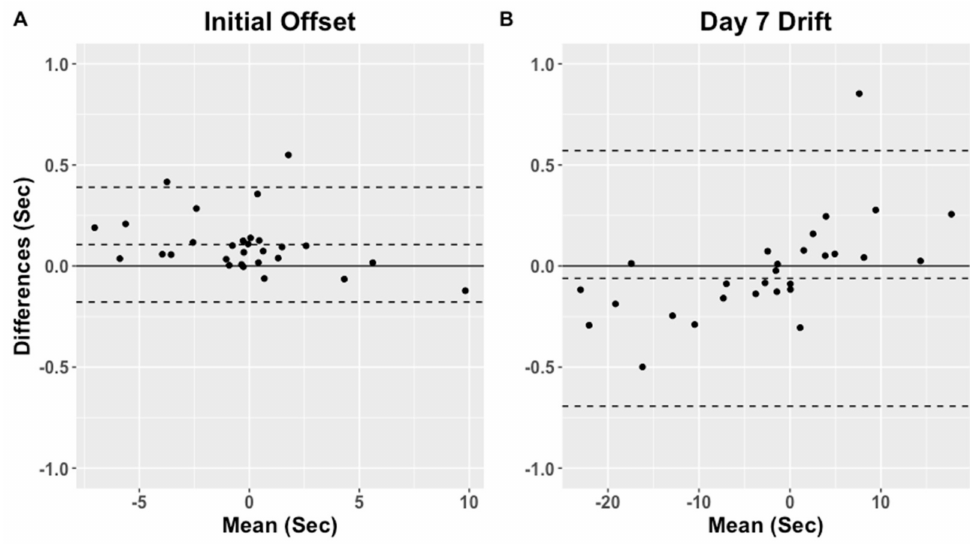
Figure 5. Bland-Altman plots of the initial offset ( A ) and the accumulated drift at day 7 ( B ) for the TH group. Subject nine was excluded from the